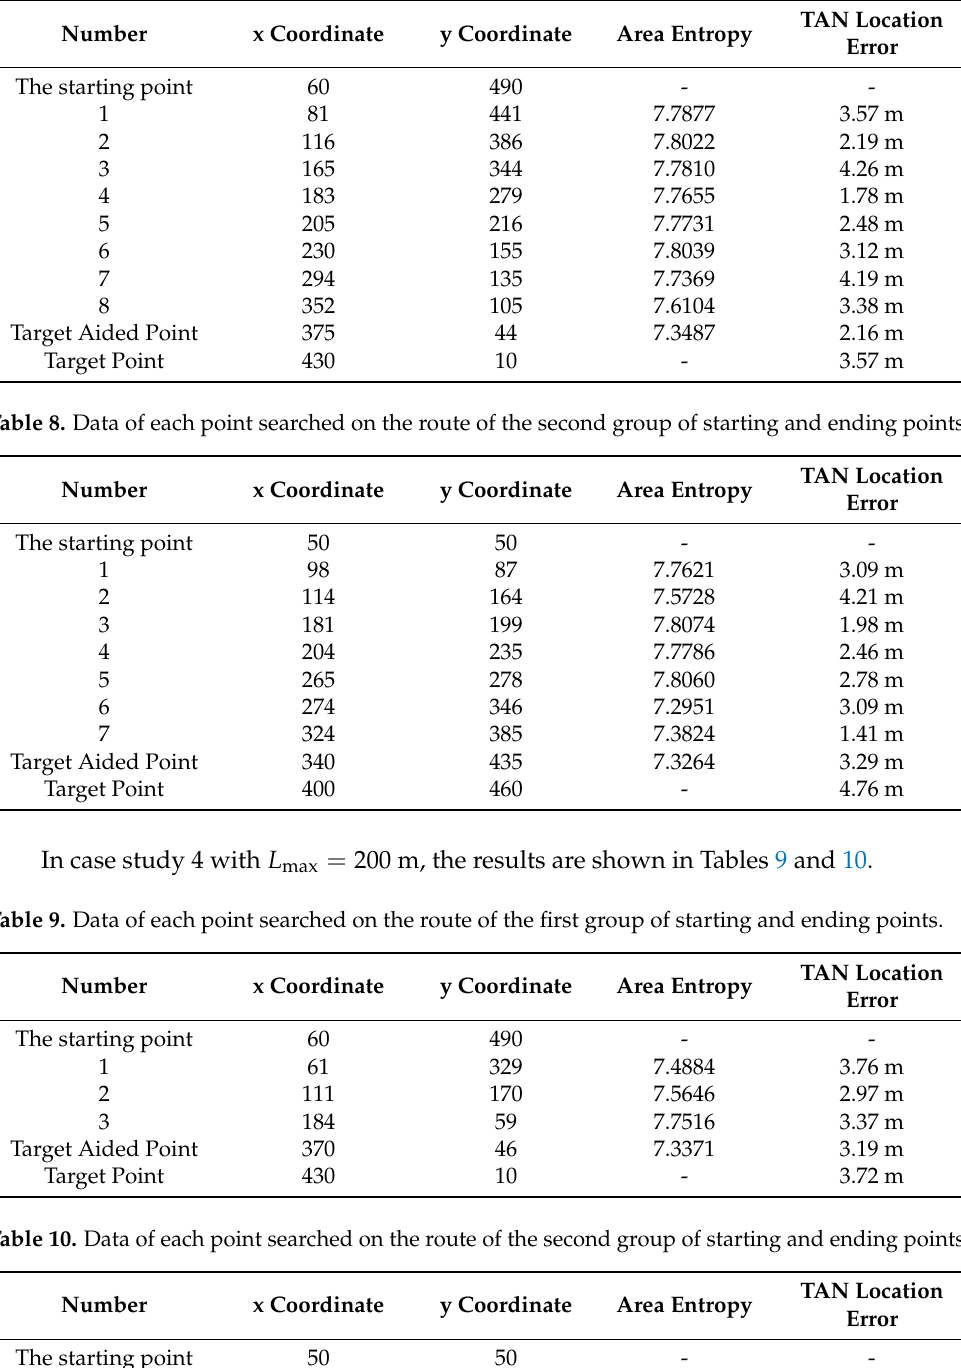
Table 7. Data of each point searched on the route of the first group of starting and ending points.